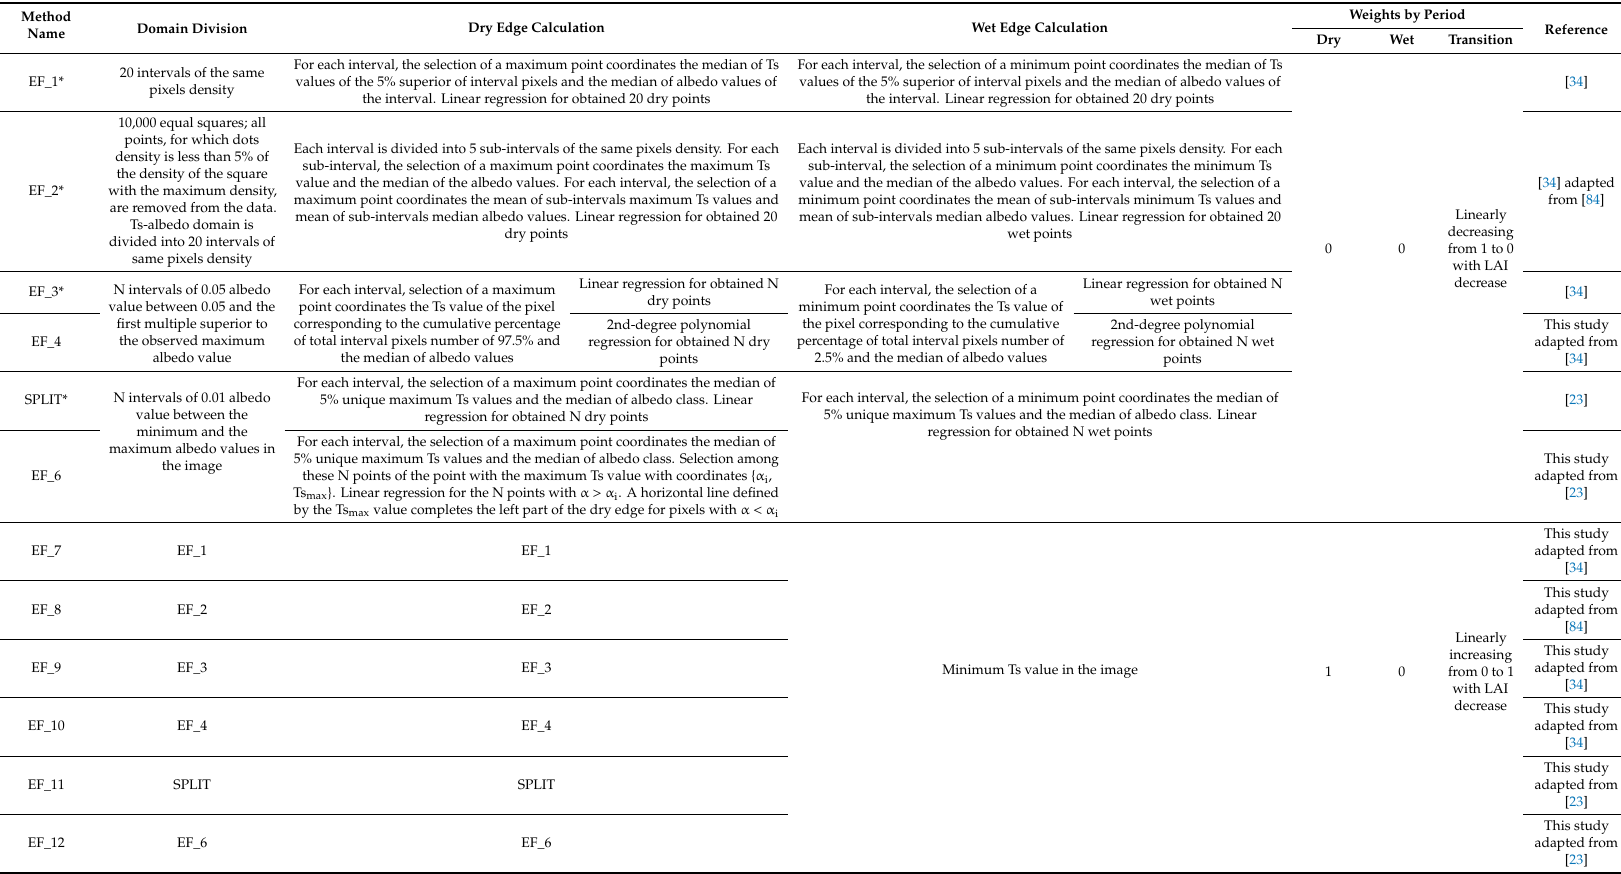
Table A2. Methods of Ts-albedo edges determination used in this study. Methods marked with an asterisk are those already included in the EVASPA v2.0